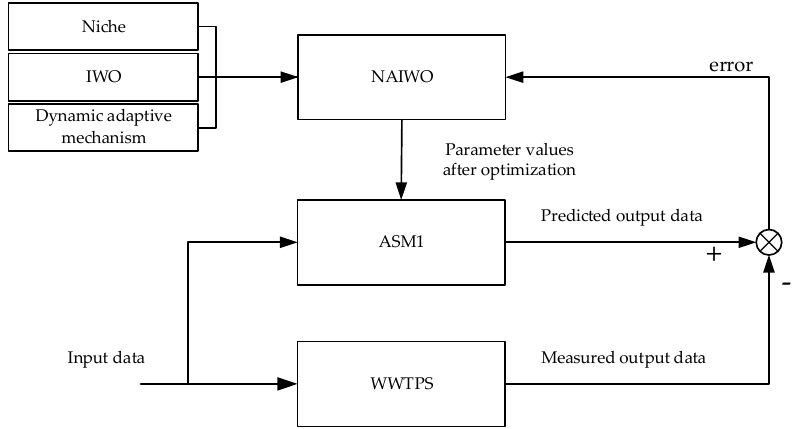
Figure 1. Schematic diagram of activated sludge model 1 (ASM1) parameter estimation using the niche-based adaptive invasive weed optimization (NAIWO) algorithm.